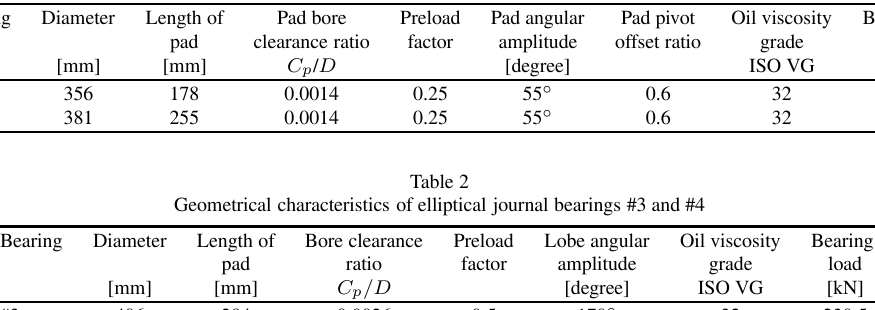
Table 1 Geometrical characteristics of tilting-pad journal bearings #1 and #2